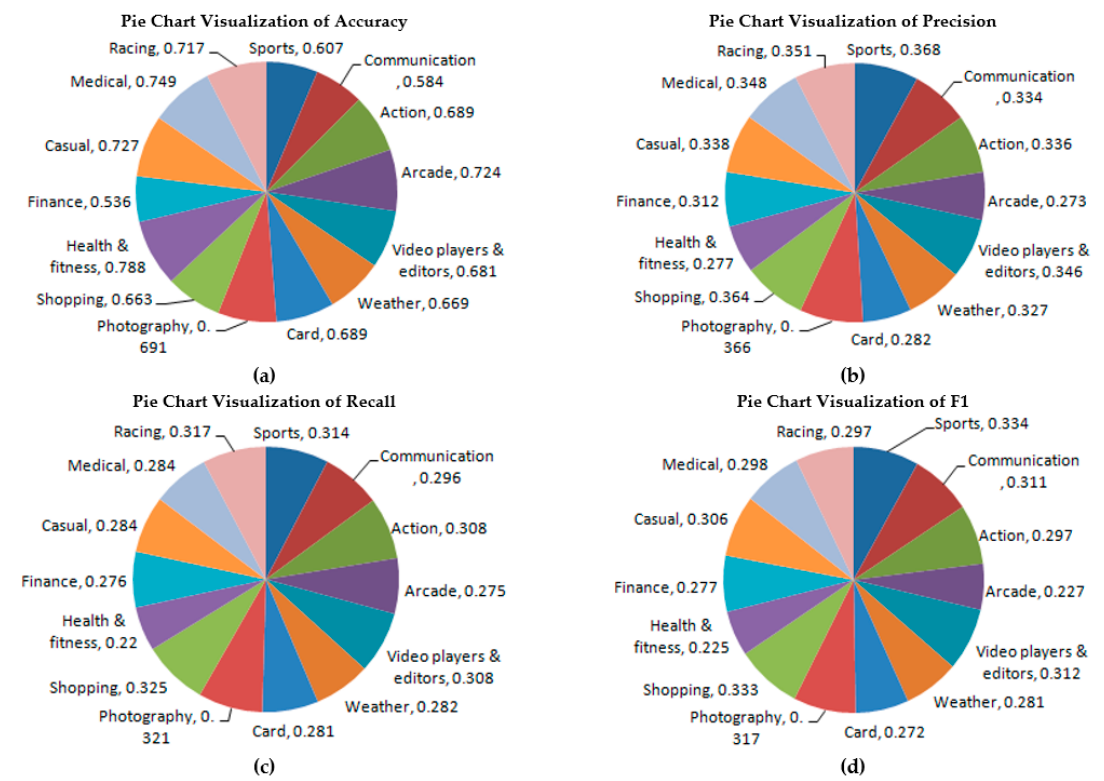
Figure 11. Pie chart visualization of di ff erent machine-learning algorithm comparison on TF based without preprocessing of data.